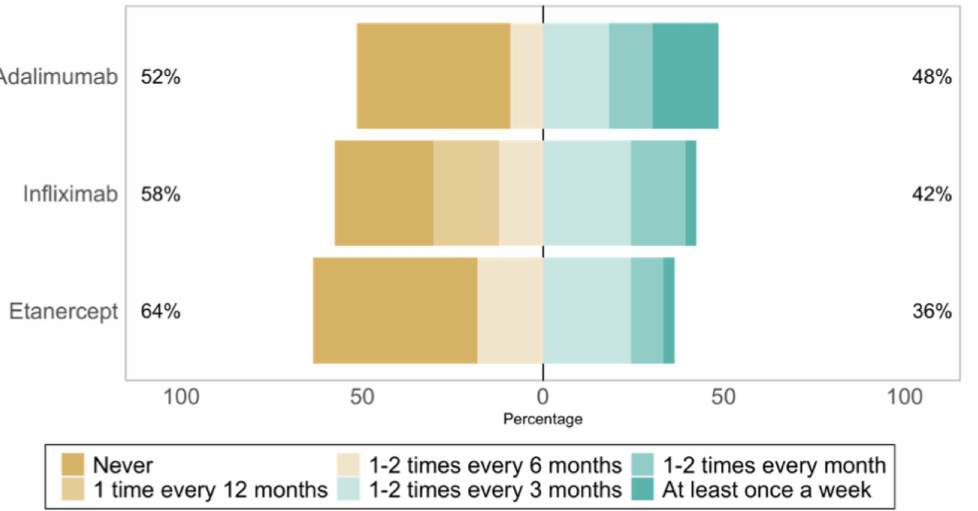
Figure 1. Prescribing frequency of reference TNF- α antagonists biosimilars, from most to least prescribed ( n =